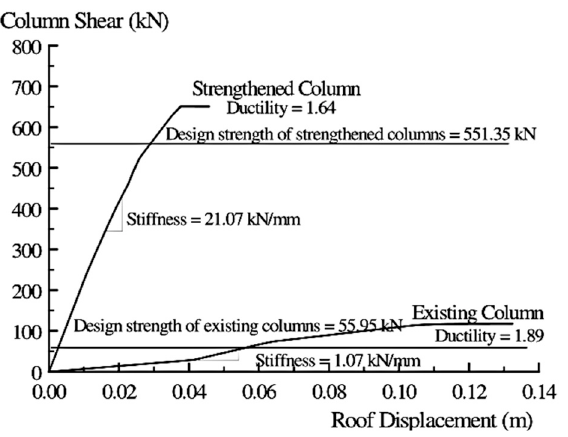
Figure 10. Comparison of the original column and reinforced column.